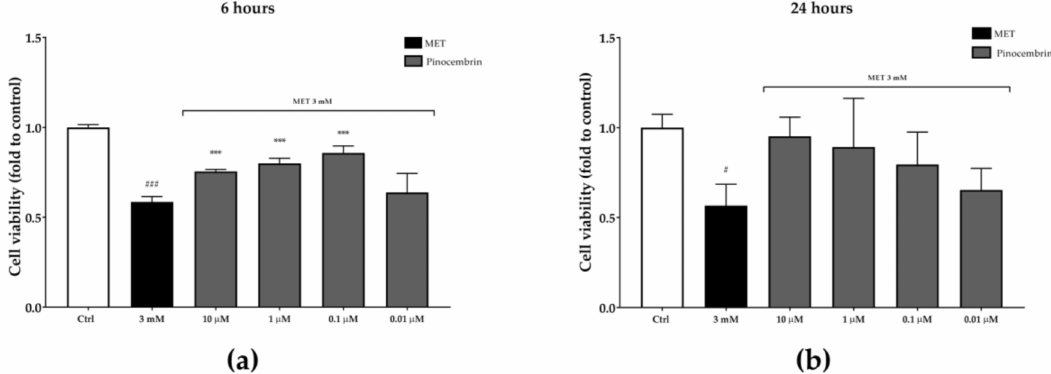
Figure 10. Protection from MET-impaired cell viability by pinocembrin after six hours ( a ) and 24 hours ( b ). *** p < 0.001 vs. stimulus; # p < 0.05 vs. control; ### p < 0.001 vs.